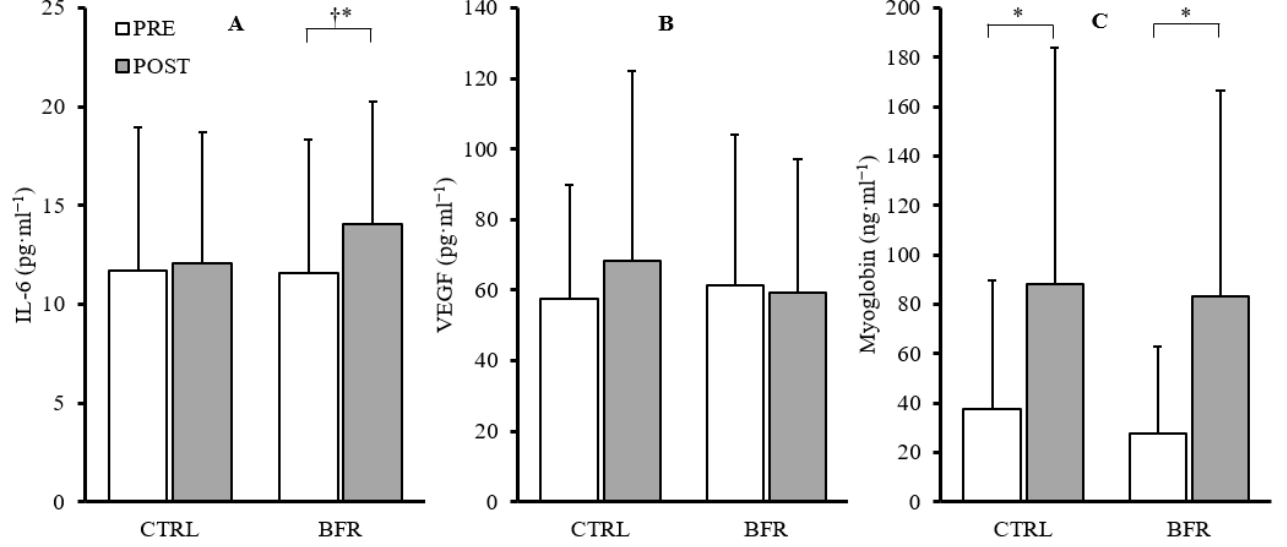
Figure 3. Changes in IL-6 ( A ), VEGF ( B ), and myoglobin ( C ) from pre (white) to post exercise (gray) in CTRL and BFR groups. † Significant difference ( p < 0.05) from CTRL. * Significant difference ( p < 0.05) within condition compared to PRE. Bars represent the mean and error bars represent standard deviation. Dots represent individual data points.